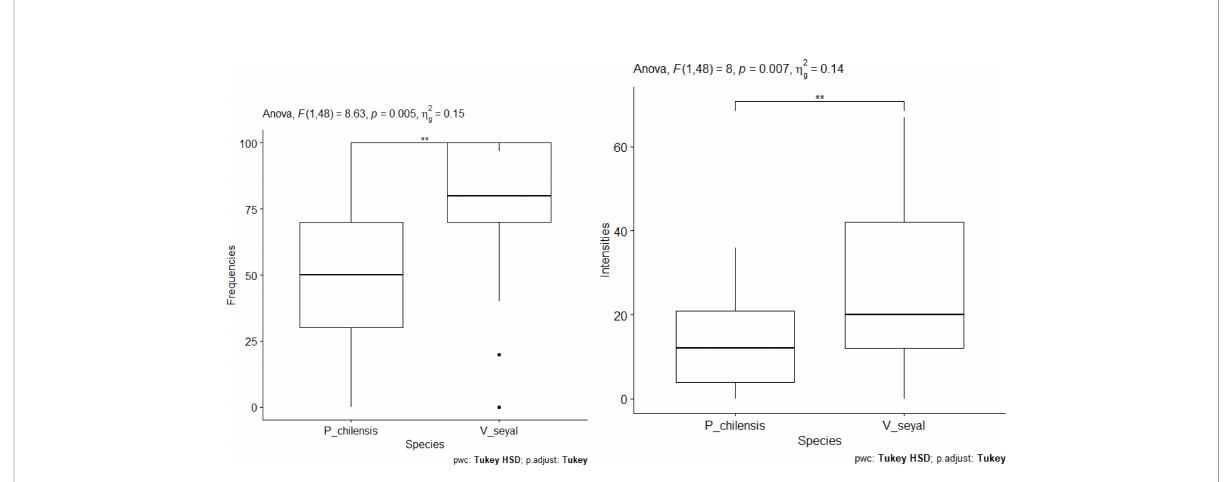
FIGURE 11 Frequencies of mycorrhization and intensities of mycorrhization according to tree species. "**" = Statistically signi fi cant difference at